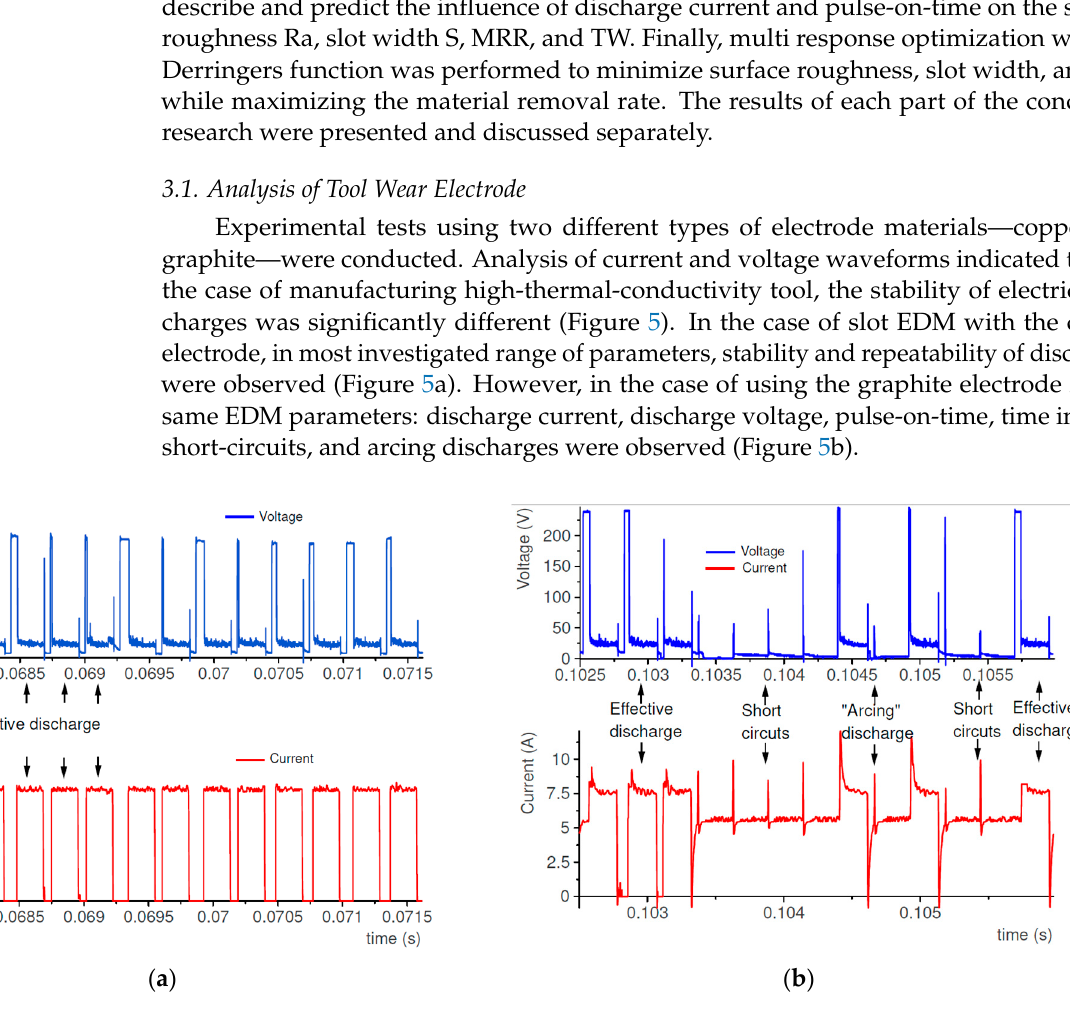
Figure 5. Current and voltage waveforms recorded during EDM for: ( a ) cooper; ( b ) graphite electrode.